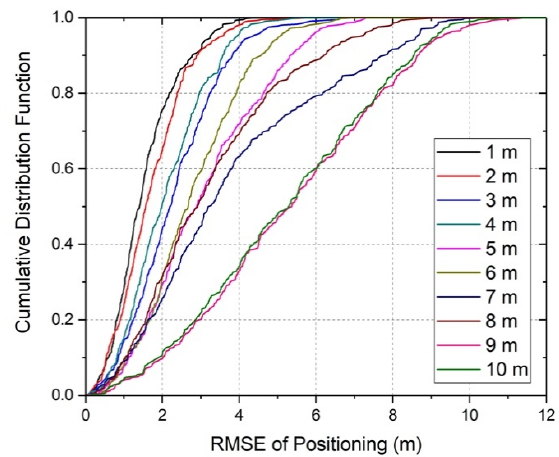
Figure 11. CDF comparison of collecting fingerprint at di ff erent space Figure 11 . CDF comparison of collecting fingerprint at different space intervals.